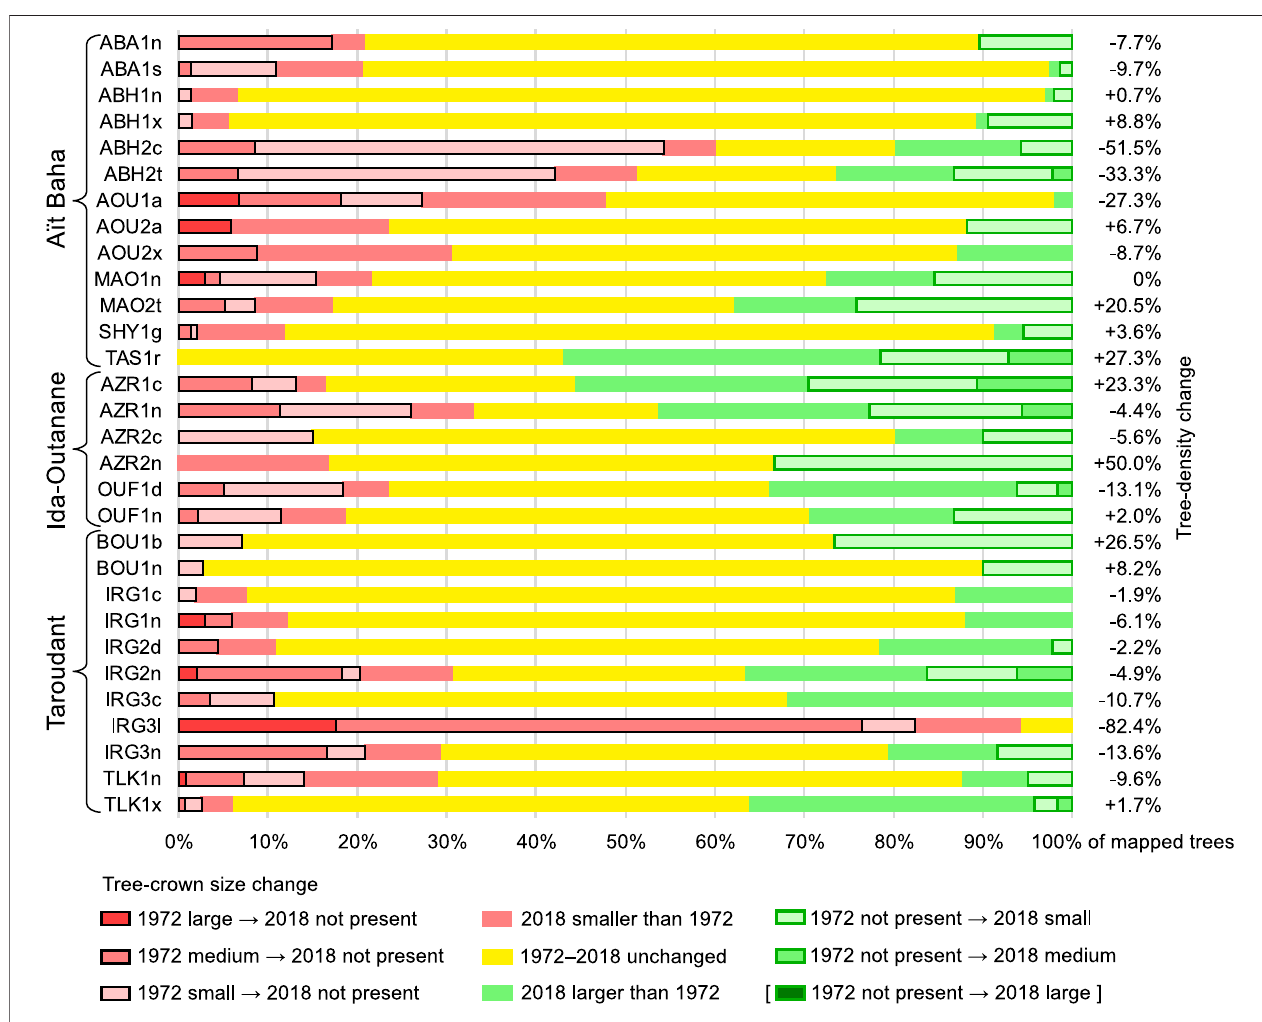
FIGURE8| Relativecontributionoftree-sizechangesforargantreesbetween1972and2018 atall30testsites,basedontheFB1972andFB2018datasets.The stacked bars show trees lost since 1972 on the left (red shades with black outlines), trees changed and unchanged in size in the middle (red, yellow and green) and new trees until 2018 on the right (green shades with green outlines). Tree-density change for each test site is given as net change of tree count per hectare.